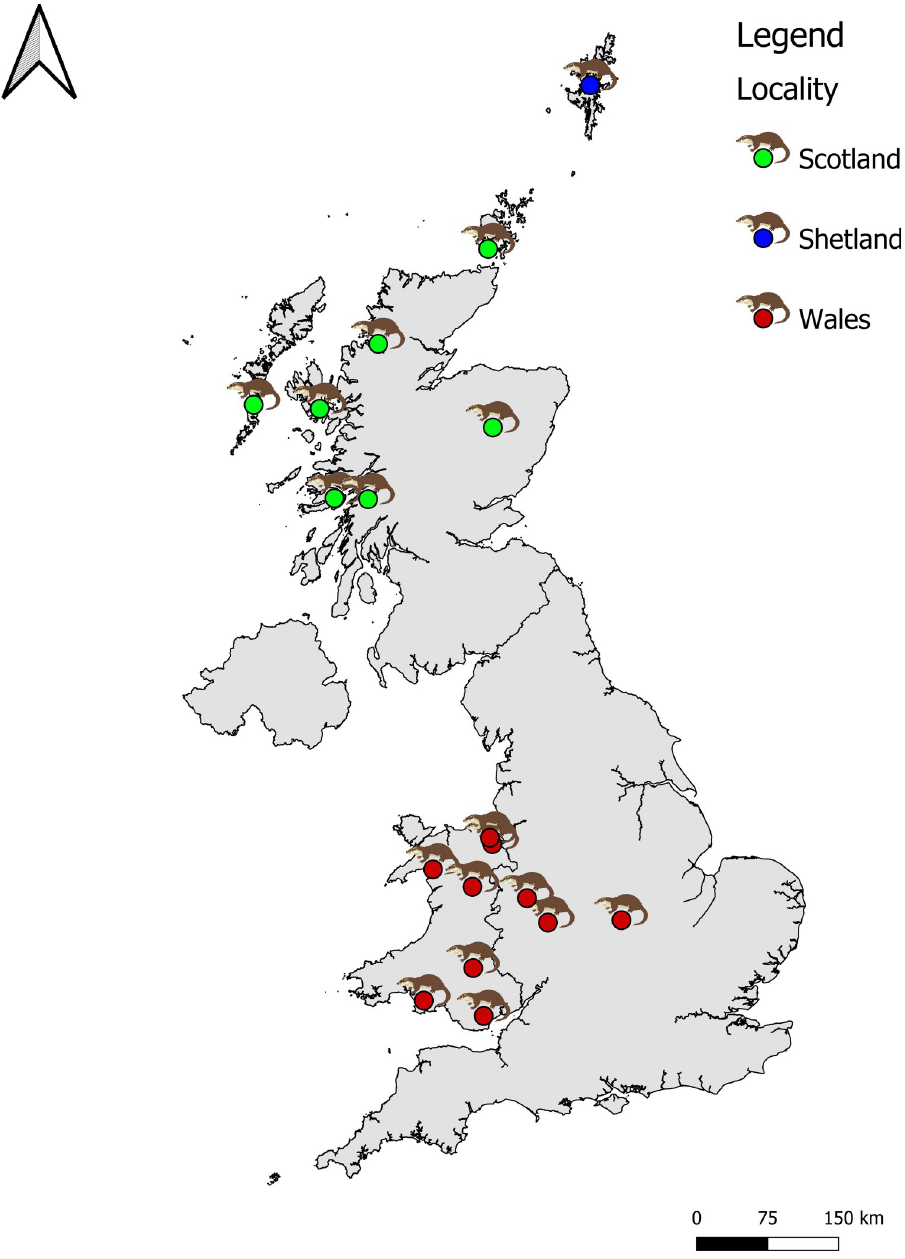
Fig 1. Geographic origin of otter skulls. Coloured points represent sampling locations. Sample size for each locality is reported in S1 Table. Country Boundaries was downloaded from www.data.gov.uk under the Open Government Licence